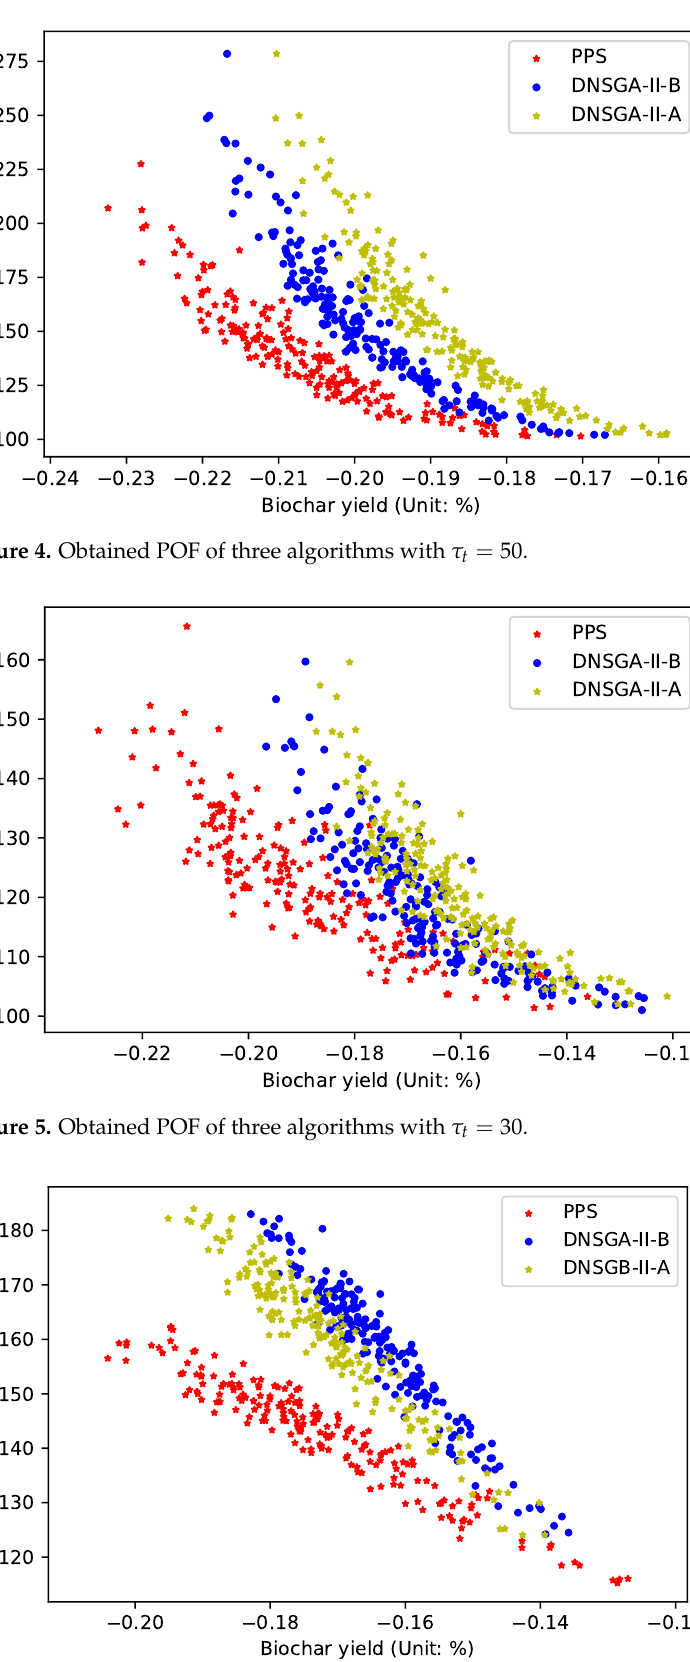
Figure 6. Obtained POF of three algorithms with τ t =